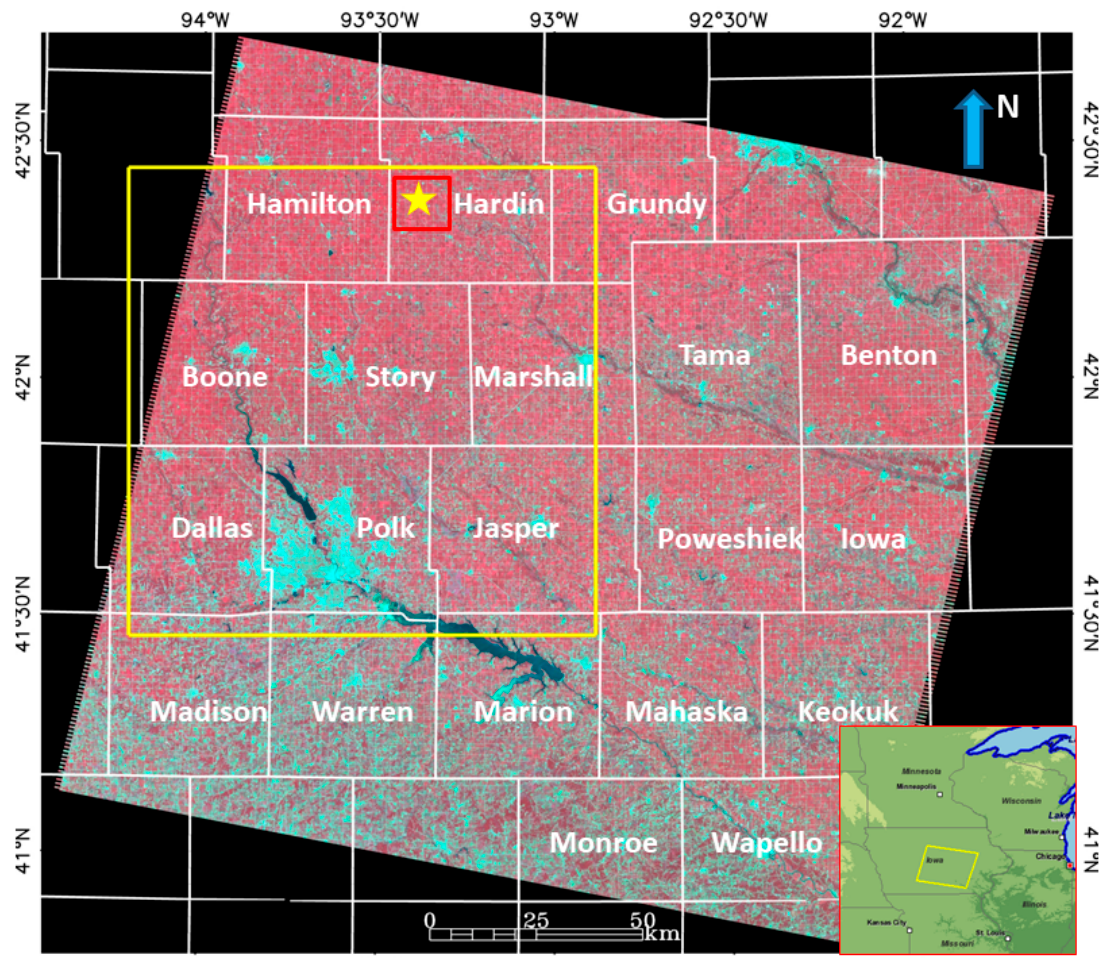
Figure 1. Study site in central Iowa (a) overlaid with the Landsat scene (path 26 and row 31, near infrared-red–green composite) containing the main portions of 20 counties (white polygons) and a Sentinel-2 tile (15TVG, yellow rectangle). The red box shows the zoom-in window for Figure 5. The yellow star shows the flux tower site.